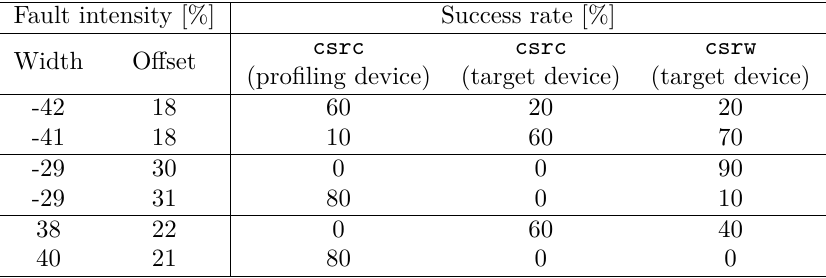
Table 9: Fault intensity parameters and their success rates with 10